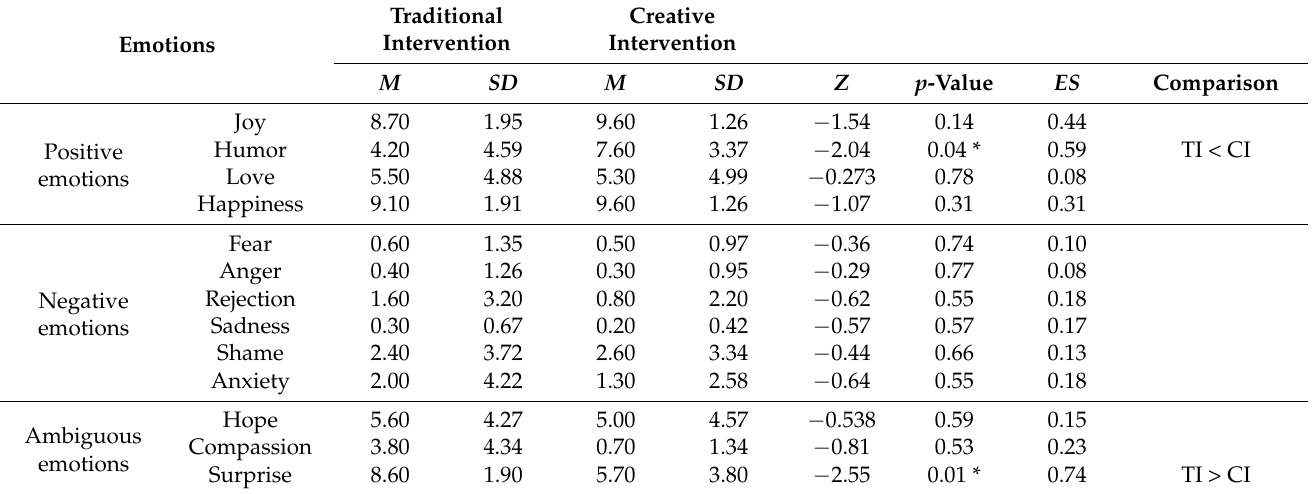
Table 3. Differences in the type of emotion induced by the traditional and the creative session.